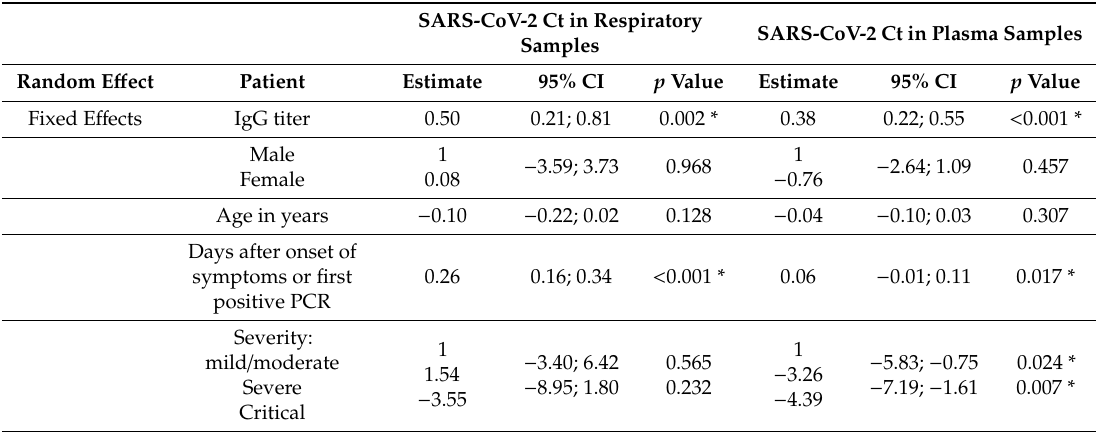
Table 2. Random intercept models with individual patients as random e ff ect to assess the association of fixed e ff ects on of severe acute respiratory syndrome coronavirus 2 (SARS-CoV-2) Ct (cycle threshold) values in respiratory and plasma samples. CI, confidence interval; Ct, cycle threshold; * p < 0.005. SARS-CoV-2 Ct in Respiratory SARS-CoV-2 Ct in Plasma Samples